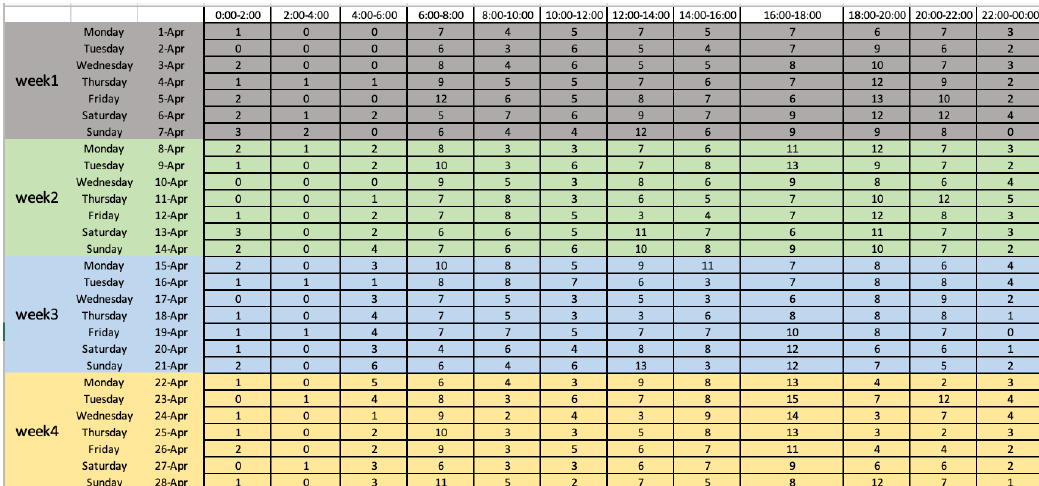
clear to see discrimination.